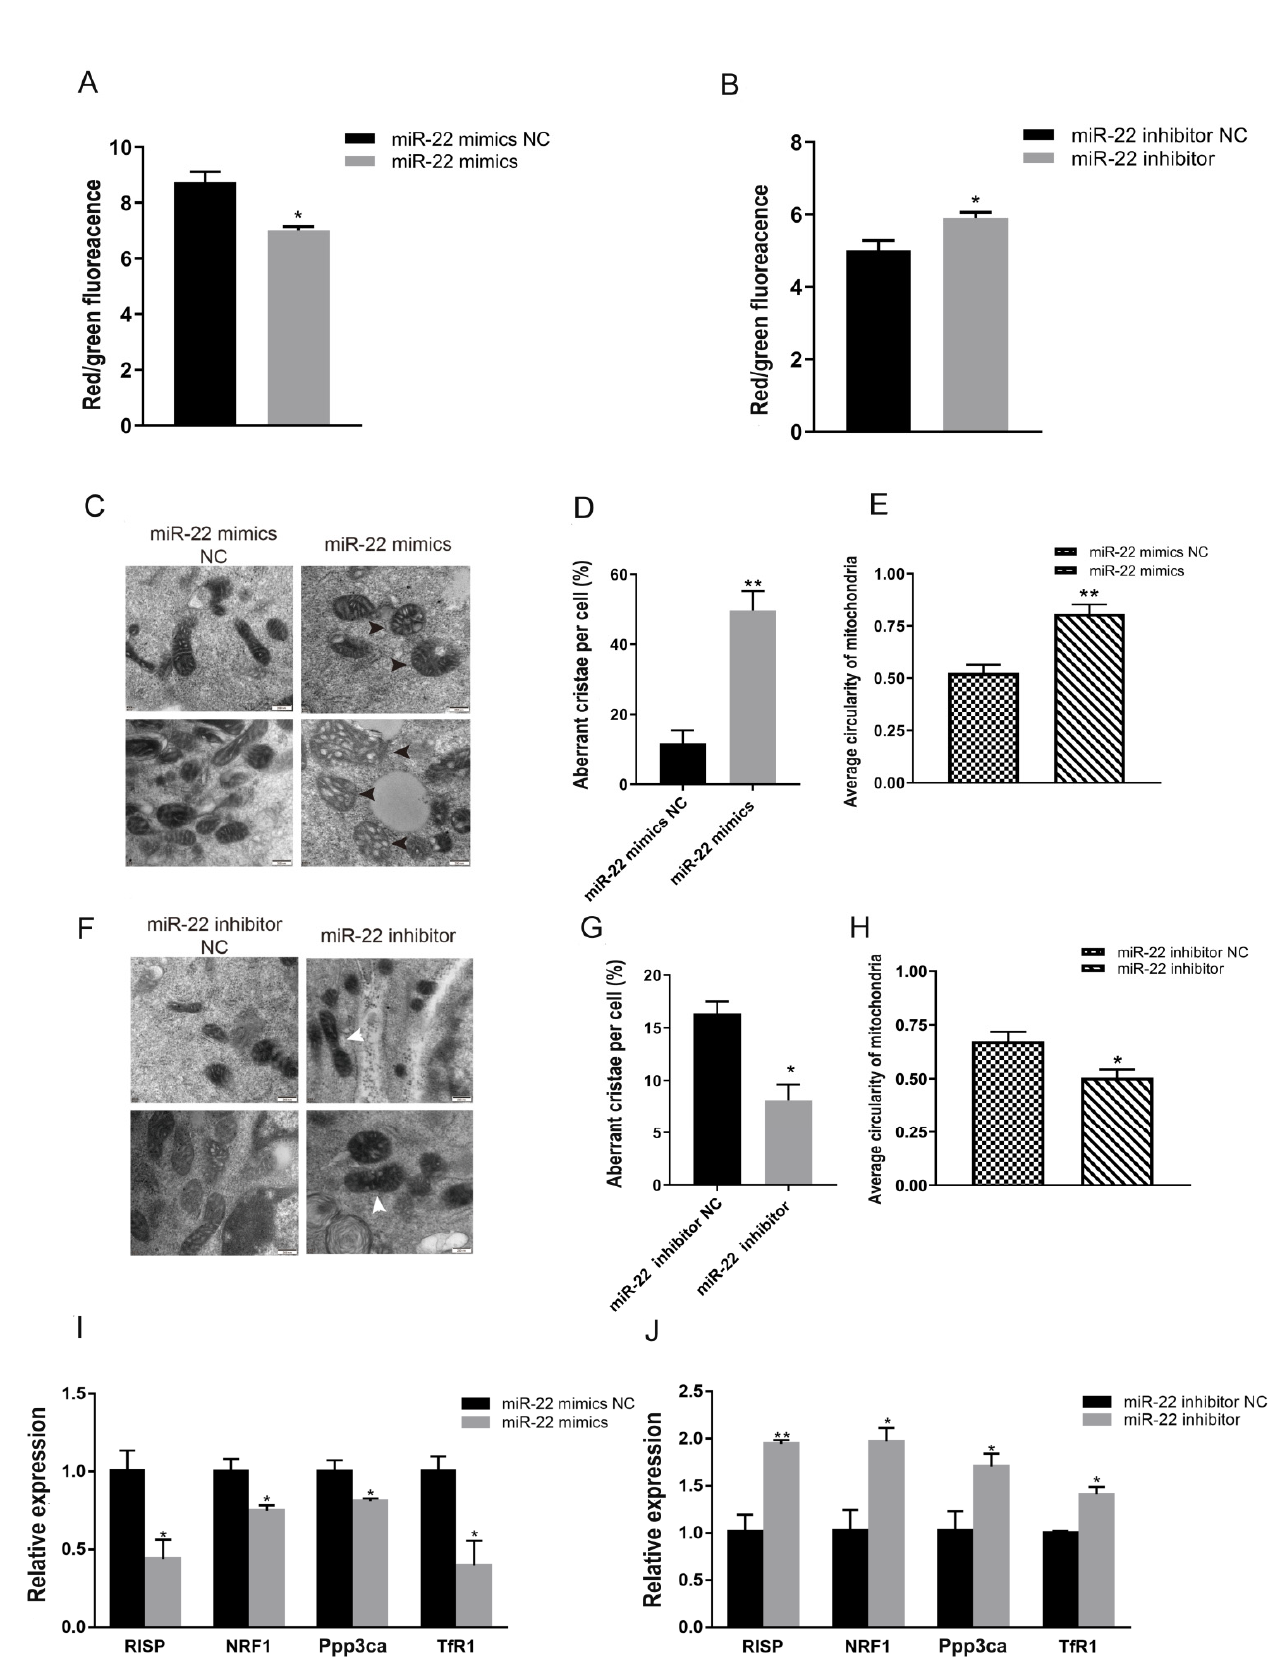
Figure 2. MiR-22 influences mitochondrial morphology in C2C12 cells. ( A ) Mitochondrial membrane Figure 2. MiR ‐ 22 influences mitochondrial morphology in C2C12 cells. ( A ) Mitochondrial mem ‐ potential in C2C12 cells was detected by JC-1 following transfection with miR-22 mimics or brane potential in C2C12 cells was detected by JC ‐ 1 following transfection with miR ‐ 22 mimics or